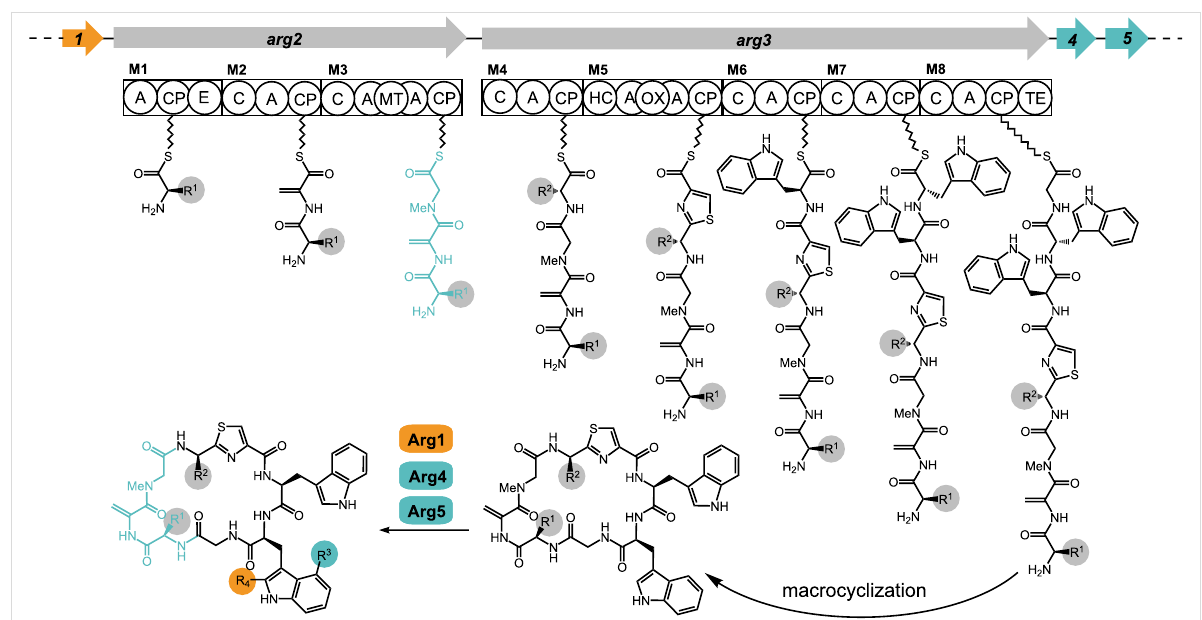
Figure 2: The biosynthetic pathway for argyrin production in Cystobacter sp. SBCb004 (Arg1, radical SAM-dependent methyltransferase; Arg2/Arg3, nonribosomal peptide synthetases; Arg4, O ‑ methyltransferase; Arg5, tryptophan 2,3-dioxygenase). The initial tripeptide of the biosynthesis of the argyrins, i.e., the target for the mutasynthons of this work, is color coded as product of the Arg2 synthetase and in the resulting final argyrin molecule.